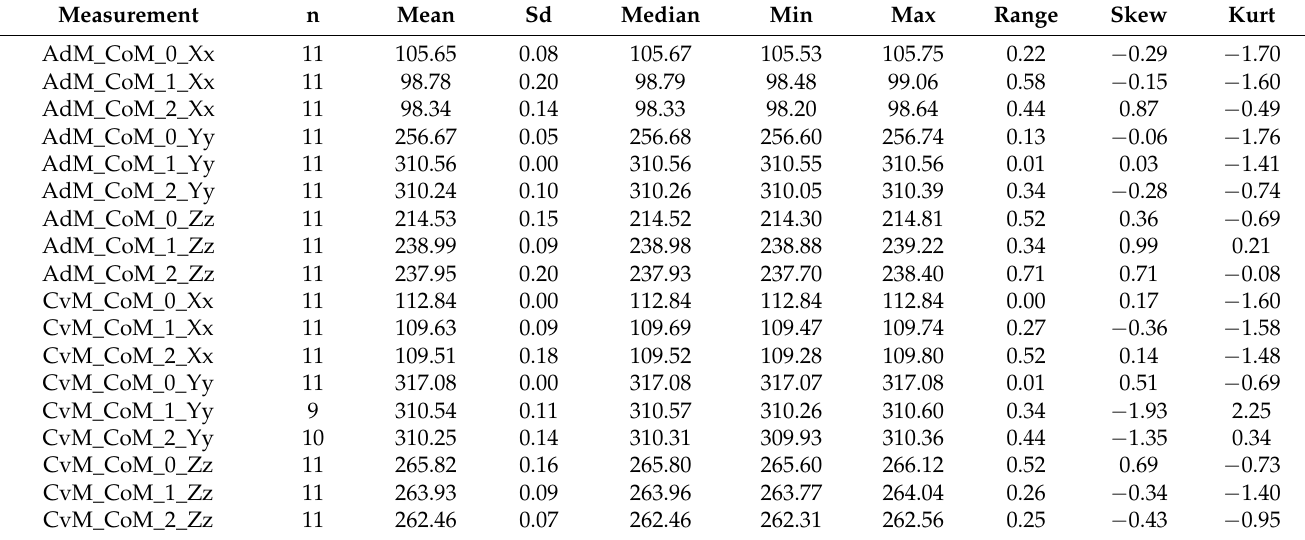
Table 7. CoM descriptive statistics for Arm I—AdM and Arm I—CvM.